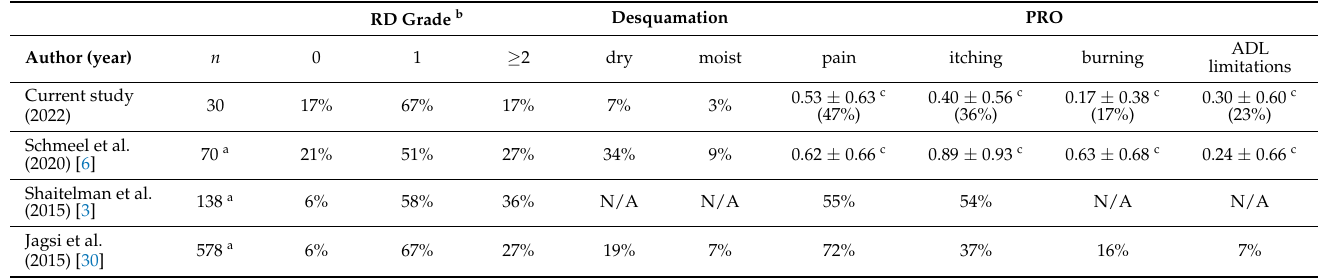
Table 5. Comparison between the current study and selected previous studies of acute toxicity inci- dence and severity upon treatment completion following hypofractionated whole-breast irradiation, including assessment of